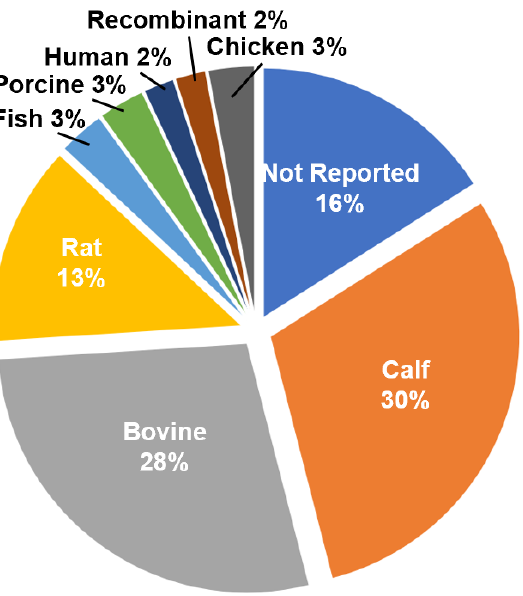
Figure 2. Distribution of collagen sources utilized in the study cohort for electrospinning.